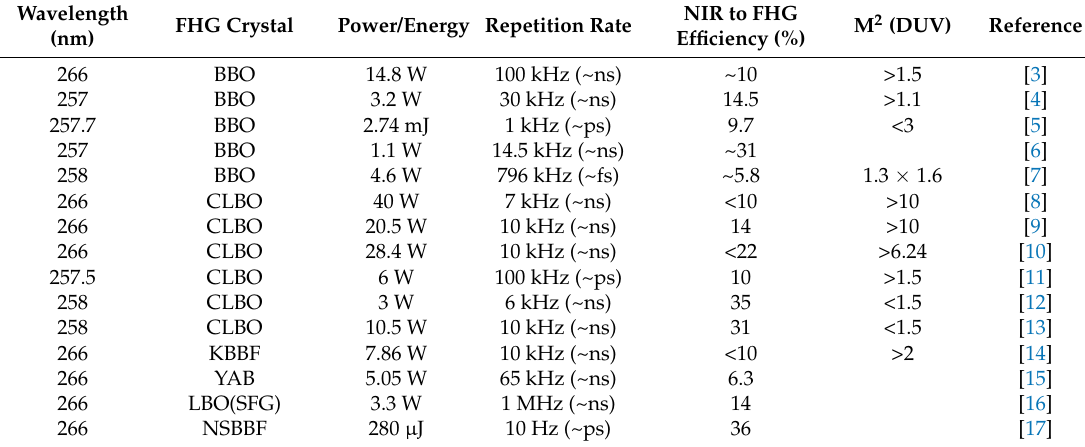
Table 1. Typical results of the solid-state DUV laser at 258 nm & 266 nm (NIR: near-infrared; DUV: deep ultra-violet; FHG: fourth-harmonics generation; BBO: β -BaB 2 O 4 ; CLBO: CsLiB 6 O 10 ; KBBF: KBe 2 BO 3 F 2